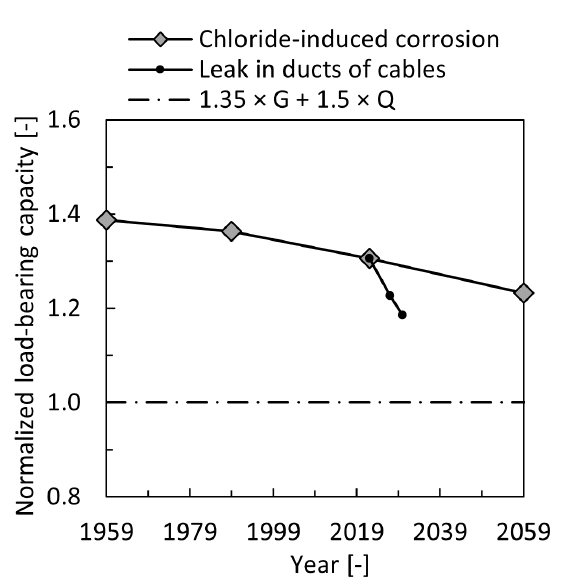
Figure 7. Prediction of the development of the design long-bearing capacity of the bridge affected by chloride- induced reinforcement corrosion and potential leak in the cable ducts of the unbonded